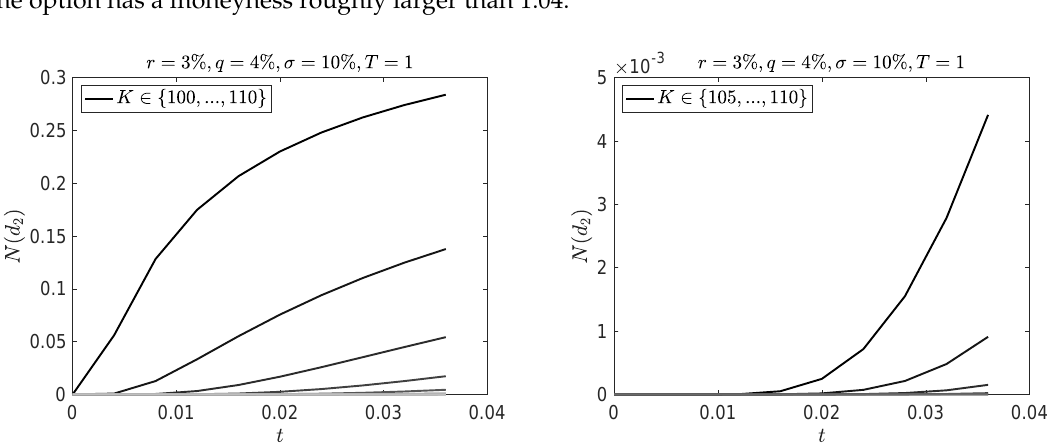
Figure 2. Probability that a call option on S is in the money at the first eight monitoring dates. Daily monitoring (250 dates for a T = 1 year maturity). The darker is the line, the higher is the strike price K . The panel on the right zooms in the one on the left focusing on more out of the money call